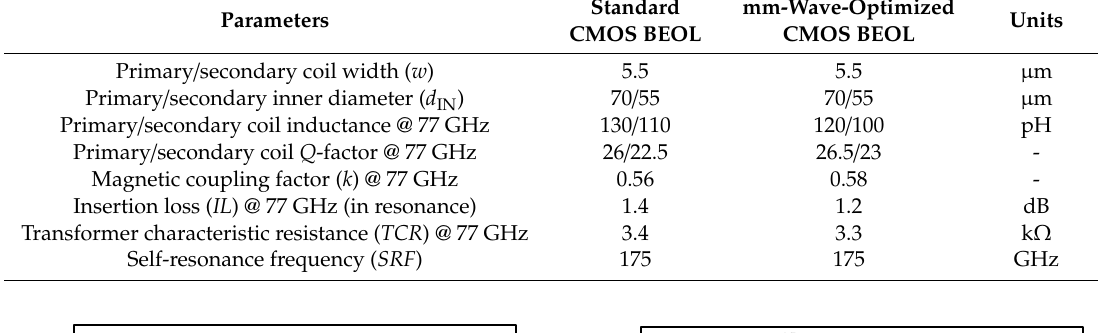
Table 2. Geometrical and performance parameter comparison for the interleaved transformer T 2.